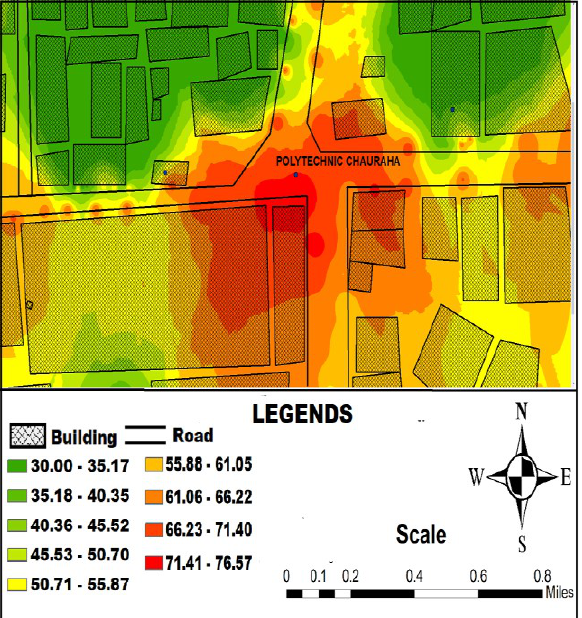
Figure 3. The noise map of Polytechnic Chauraha evening slot with value variation is between 30.00 to 76.57. Barrier and distance attenuation is also calculated and mapped Secondly, for Hazratganj Chauraha where the crossing is surrounded by large buildings and complexes. The main source is the vehicles, environmental noise, and market area noise, that remains throughout the day. This comes in a medium noise zone area. Figure 4 shows the noise map for the morning slot.